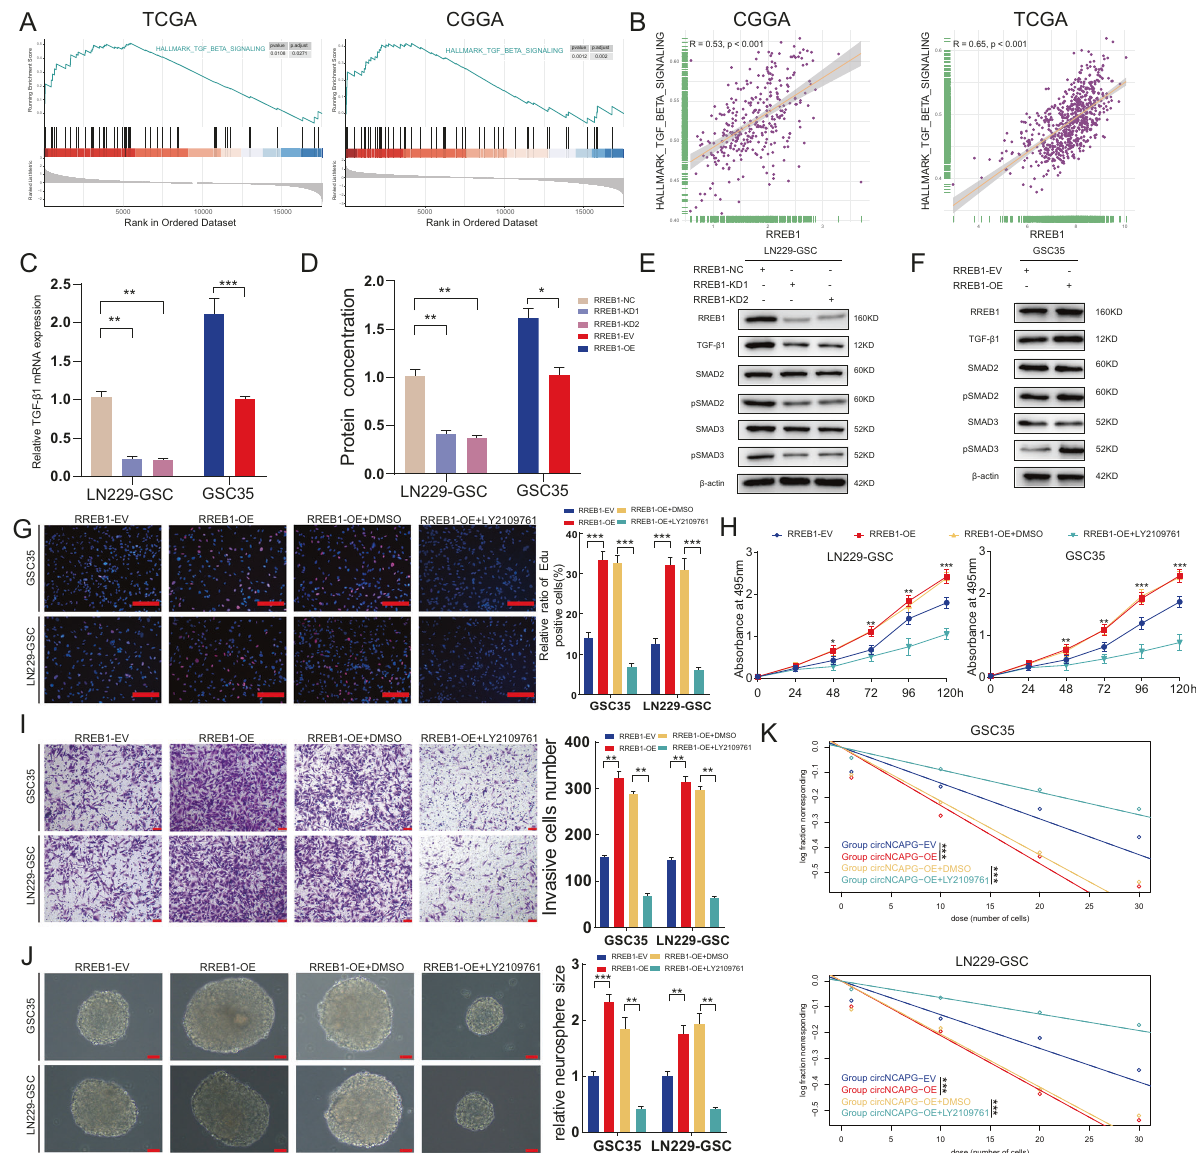
Fig. 7 TGF- β 1 signaling pathway is functional downstream intermediary for RREB1 in promoting the malignant phenotype of GSCs. A GSEA analysis revealed that the HALLMARK_TGF_BETA_SIGNALING signature was obvious enriched in higher RREB1 expression group in TCGA and CGGA cohorts. B The correlation between the HALLMARK_TGF_BETA_SIGNALING signature enrichment score assessed via ssGSEA and RREB1 expression in TCGA and CGGA cohorts. C The qPCR assays revealed the mRNA expression of TGF- β 1 in GSCs with RREB1 knockdown and overexpression treatment. D The ELISA showed the protein concentration of TGF- β 1 in GSCs with RREB1 knockdown and overexpression treatment. E , F The western blotting showed the protein expression levels of TGF- β 1 pathway after RREB1 knockdown ( E ) and overexpression ( F ) treatment. G – K The MTS ( H ), EDU ( G ), transwell ( I ), neurosphere formation ( J ), limiting dilution neurosphere formation ( K ) showed that RREB1 affected the malignant phenotype of GSCs and was reversed by LY2109761 treatment. All results are presented as the mean ± SD (three independent experiments). * p < 0.05; ** p < 0.01; *** p < 0.001.